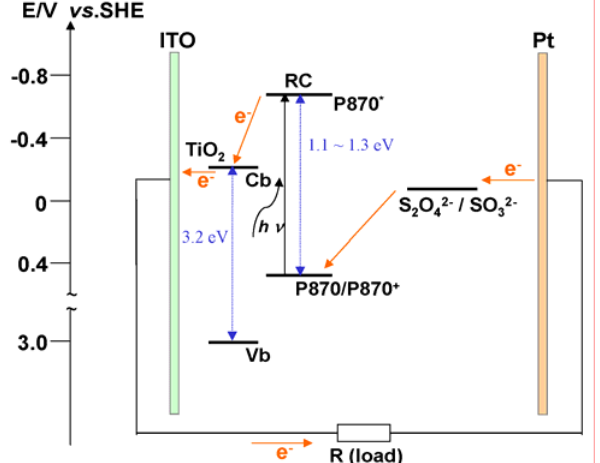
biophotovoltaic cell. Figure 4. Operation of the RC-sensitized nanocrystalline TiO 2 The photoanode is RC/TiO film and the counter-electrode is Pt. The 2 electrolyte is Tris-HCl buffer containing 8 mM sodium dithionite (pH 8.0). P870: bacteriochlorophyll dimer, the primary donor. Cb: conduction band. Vb: valence band.